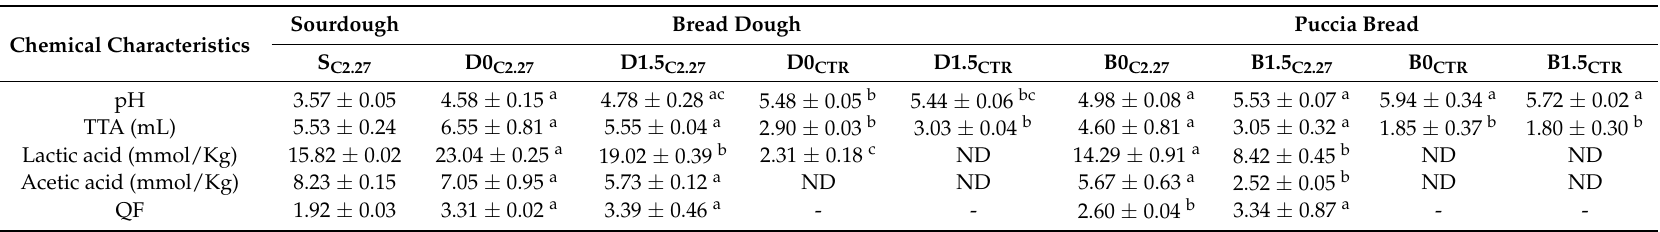
Table 6. Chemical characteristics of liquid sourdough (S C2.27 ) and puccia bread doughs made with liquid sourdough, without salt (D0 C2.27 ) or with 1.5% salt (D1.5 C2.27 ), bread doughs made with baker’s yeast, without salt (D0 CTR ) or with 1.5% salt (D1.5 CTR ), and puccia breads (B0 C2.27 , B1.5 C2.27 , B0 CTR , B1.5 CTR ) obtained by baking of the bread doughs in bakery